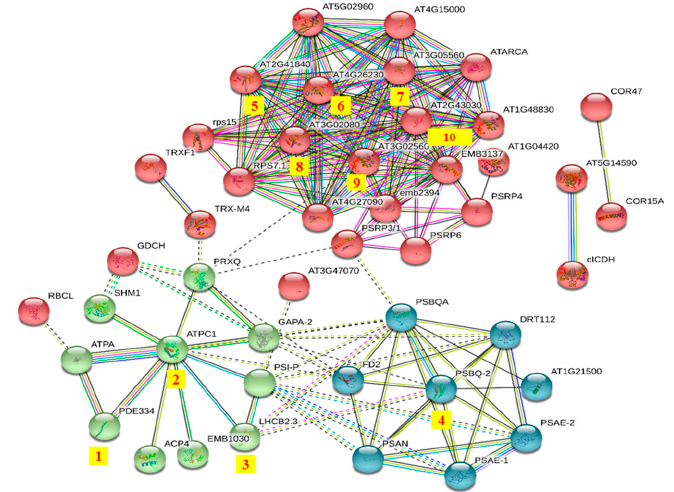
Figure 3. Protein–protein interaction network of differentially regulated proteins (DRPs) in opr3-1 under MeJA-treatment. Red group: protein synthesis; green group: energy metabolism; blue group: photosynthesis .